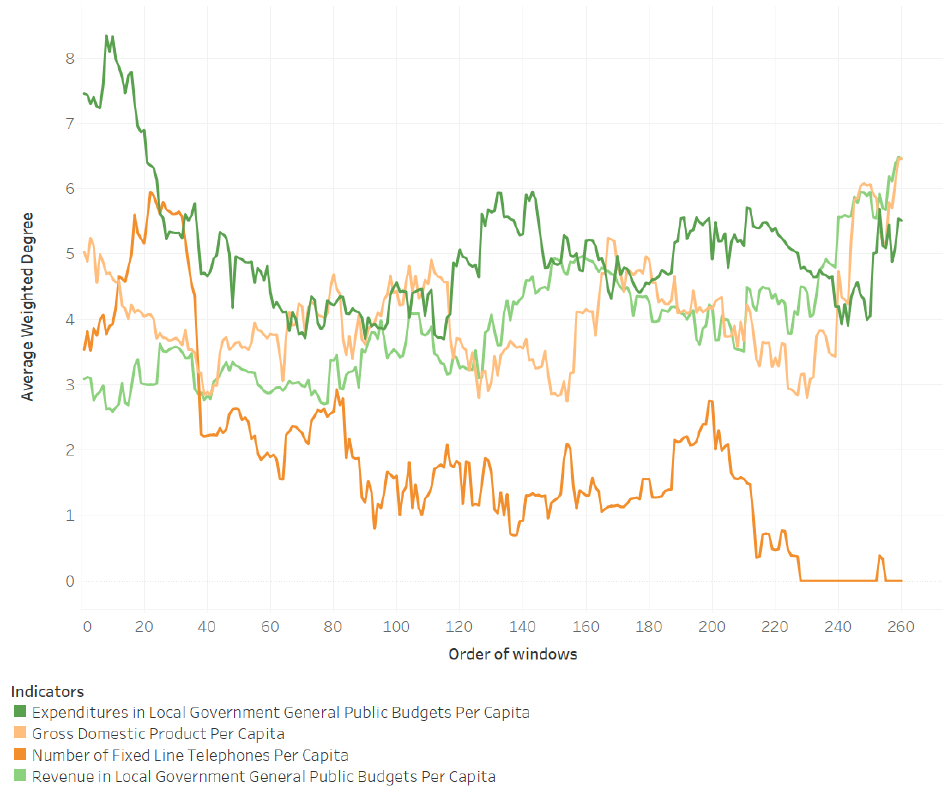
Figure 4. The trends of AWD for 14 important indicators along the total index. Table 2. The description of the trends of AWD for 14 important indicators along the total index.